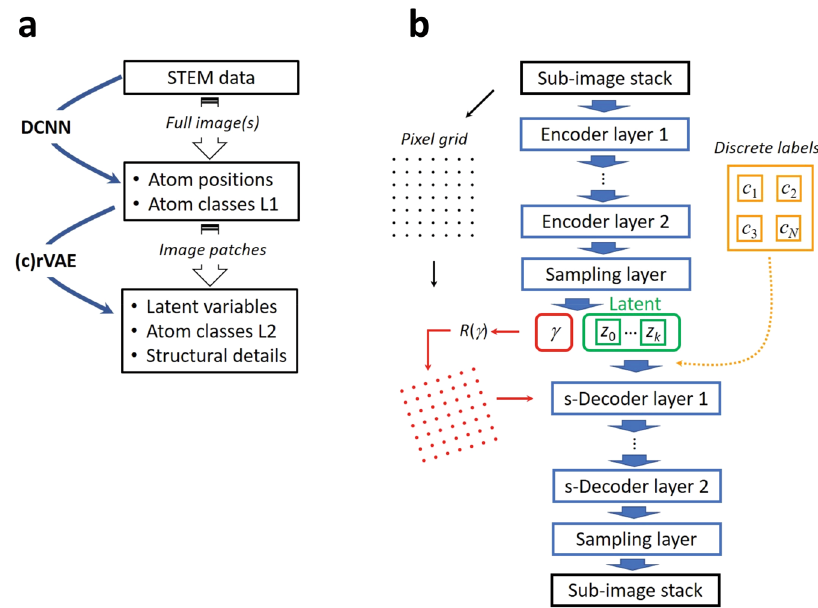
Fig. 2 Schematic of the Bayesian local crystallographic and c( r )VAE work fl ow. a General work fl ow of deep Bayesian local crystallographic analysis. b Schematic of (conditional) rotational variational autoencoder, ( c ) r VAE, work fl ow. In ( c ) r VAE, the encoder layers can be either fully connected or convolutional, whereas the decoder layers are always fully-connected layers (in the current implementation, inclusion of convolutional layers breaks the rotational